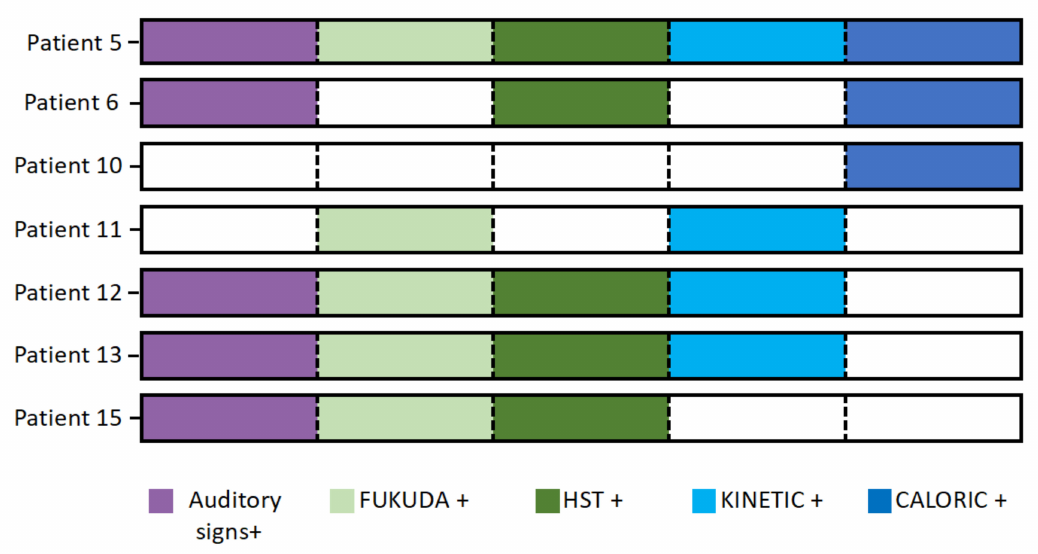
Figure 3. Association of clinical and paraclinical vestibular signs among the 7 patients with vestibular syndrome. Auditory signs: tinnitus, aural fullness or hearing loss; Fukuda + : positive Fukuda test; HST + : nystagmus triggered by head shaking test; kinetic + : kinetic test showing a directional preponderance over 2%; caloric + : caloric test showing a di ff erence of 25% or more between the response of the two